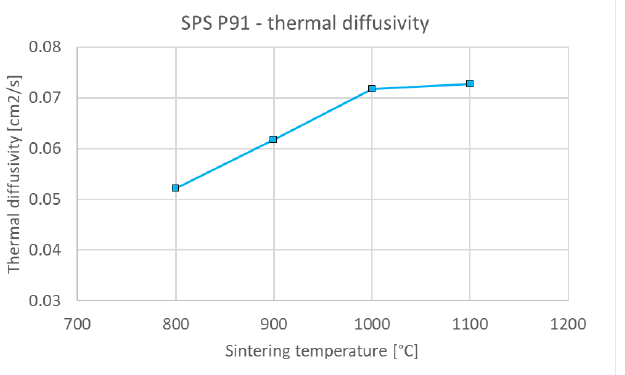
Figure 7. Influence of sintering temperature on the porosity of steel compacts.